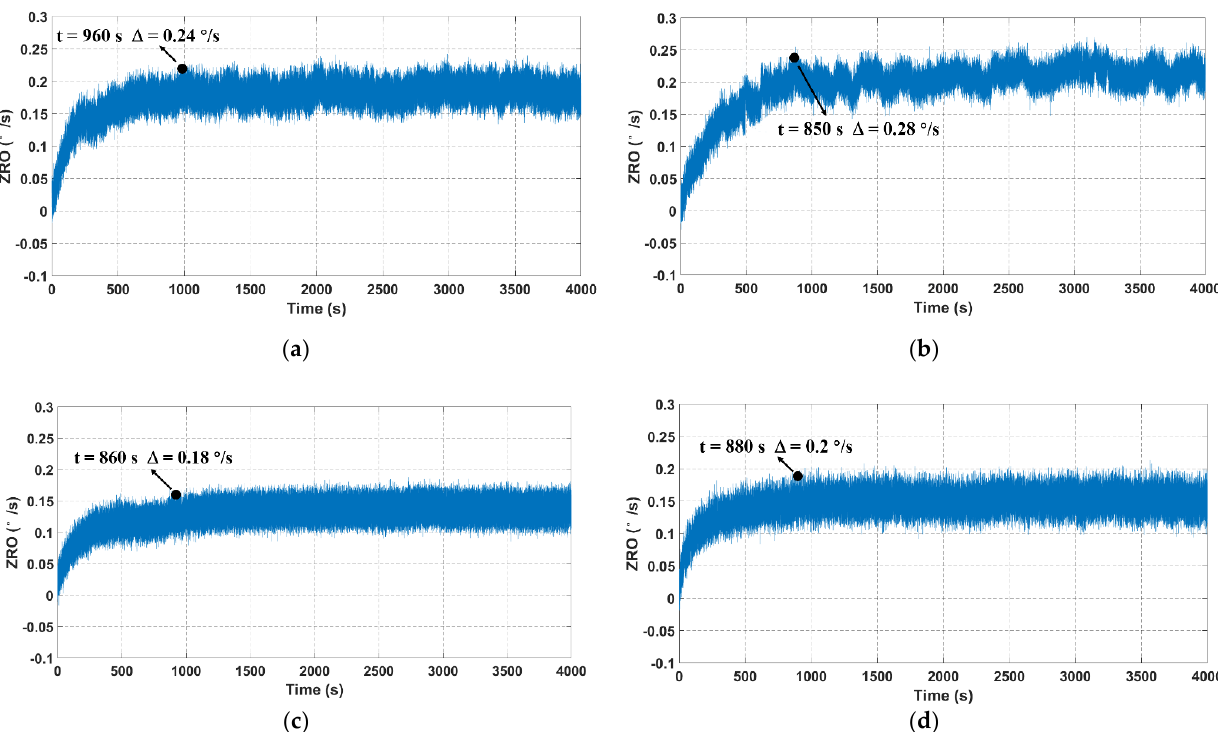
Figure 11. ZRO result comparisons between four stress-released TFGs. ( a )-( d ) represent the ZRO of four stress-released TFGs (samples 1-4).